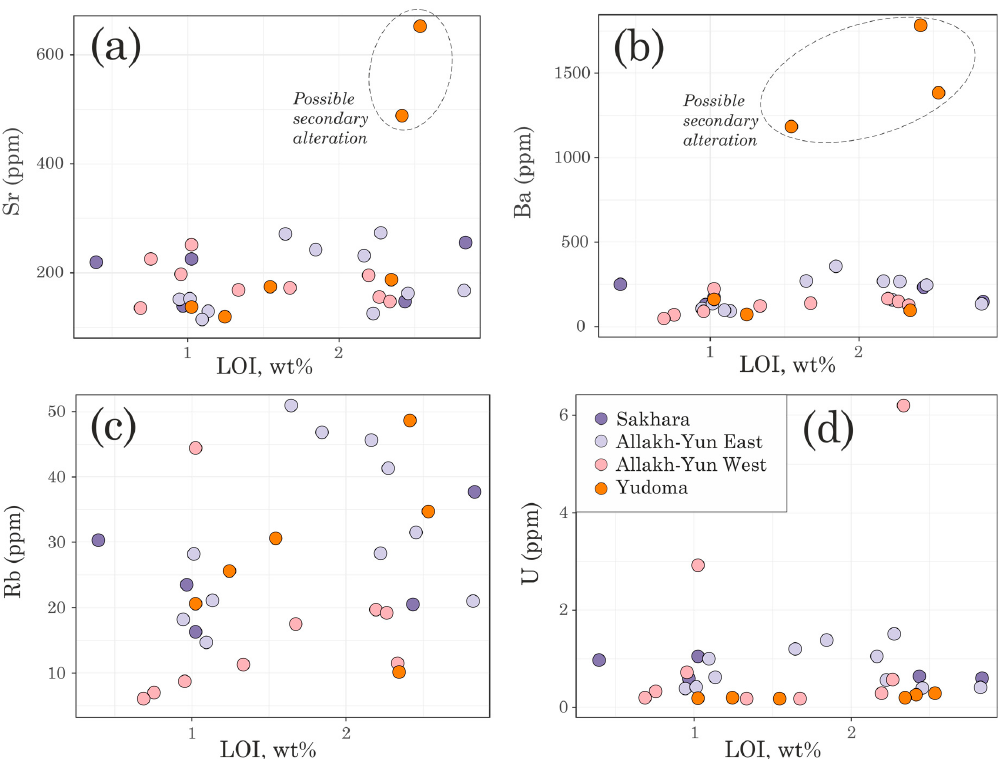
Figure 8. Plots of ( a ) Sr (ppm), ( b ) Ba (ppm), ( c ) Rb (ppm), and ( d ) U (ppm) vs. loss on ignition (LOI) (wt%) for the Sette-Daban event dolerites. Minerals 2020 , 10 , x FOR PEER REVIEW